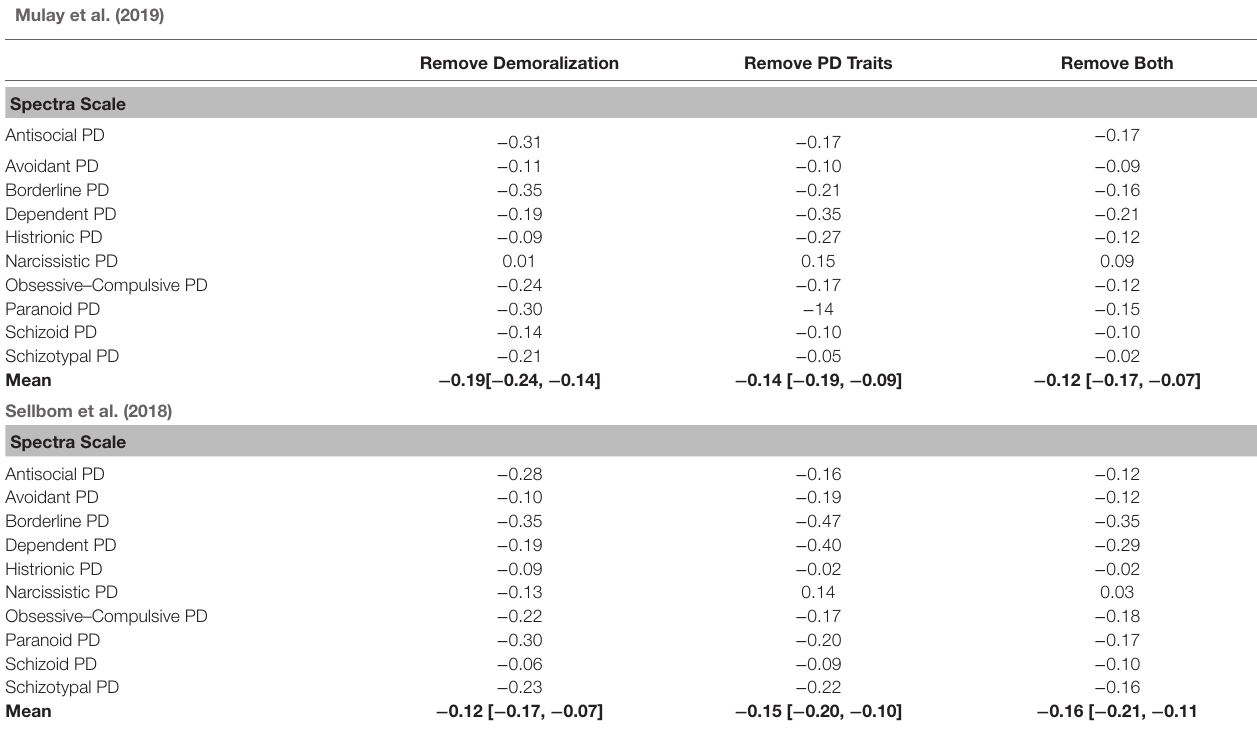
TABLE 3 | Partial correlations between SIPP-18 LPF Factor Score and Mulay et al. (2019) and Sellbom et al. (2018) PD Spectra scales controlling for Demoralization (RCdem) and Maladaptive Personality Traits (PSY-5). Mulay et al. (2019) Remove Demoralization Remove PD